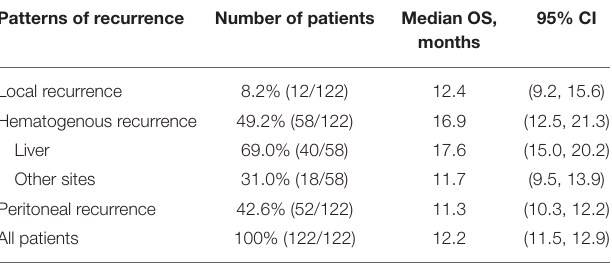
TABLE 3 | The prognosis of gastric cancer patients with recurrence ( n = 122). Patterns of